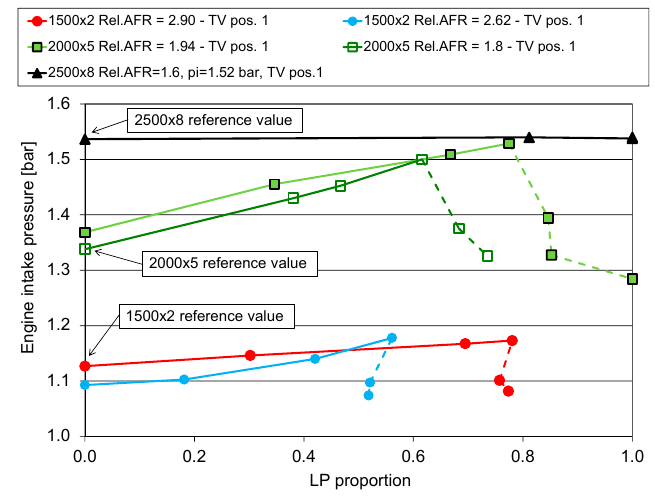
Figure 4. Engine intake pressure as a function of LP proportion in different operating modes.